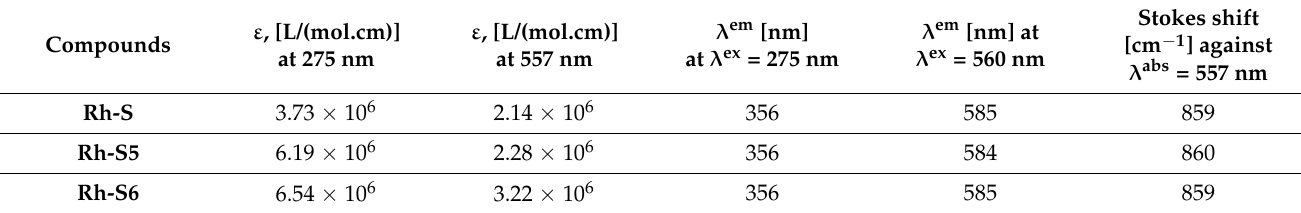
Figure 4. The UV–Vis absorbance spectra of equal concentration of Rh-S, Rh-S5, and Rh-S6 at pH Figure 4. The UV – Vis absorbance spectra of equal concentration of Rh-S, Rh-S5, and Rh-S6 at 7.413 (phosphatic buffer solution) against water. pH 7.413 (phosphatic buffer solution) against water. Table 2. Photophysical characterizations of rhodamine-peptide Table 2. Photophysical characterizations of rhodamine-peptide derivatives.